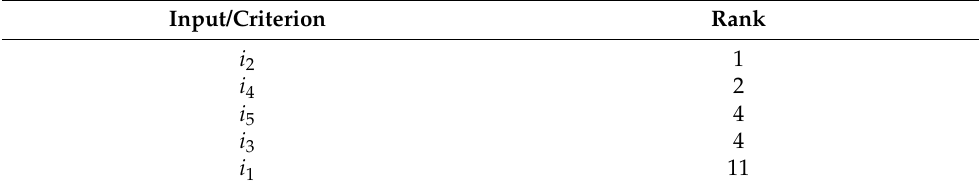
Table 3. Ranks of criteria inputs after introducing white cards.